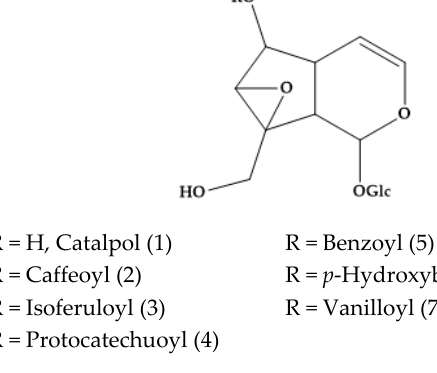
Figure 1. Catalpol and aucubin derivatives described in several Veronica plants, including sect.